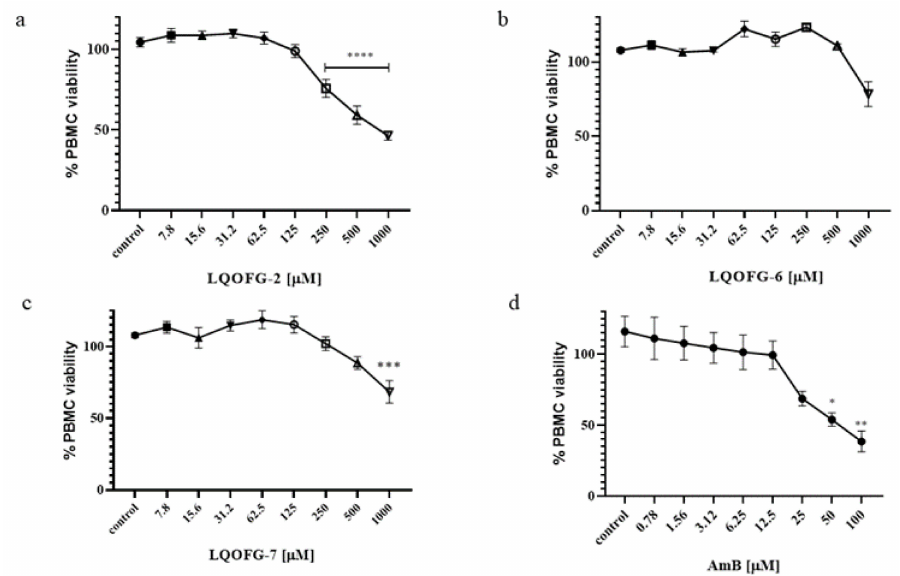
Figure 3. PBMC % viability after LQOFG-2 ( a ), LQOFG-6 ( b ), LQOFG-7 ( c ), and AmB ( d ) treatment. Data are mean ± SEM from three independent experiments in triplicate. (control): represents untreated control. * p ≤ 0.05, ** p ≤ 0.01, *** p ≤ 0.001, **** p ≤ 0.0001 by analysis of variance (ANOVA) with the post hoc Tukey